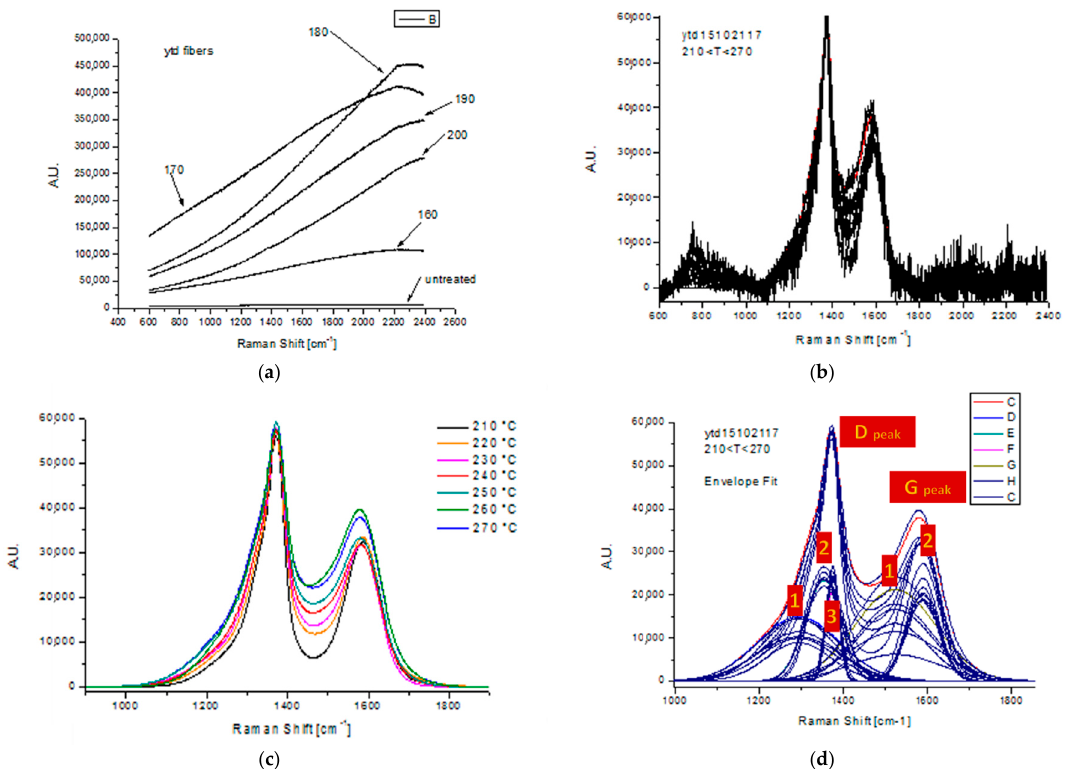
Figure 12. Raman spectra of thermally treated fibers: ( a ) isothermally treated at temperature between 160–200 °C. Isothermally treated at temperature between 210–270 °C, ( b ) after Baseline correction and subtraction, and ( c ) after noise reduction and D-peak normalization. In ( d ) the fitting process in the entire spectrum is demonstrated to measure the D-and G-peak area as presented in Table A1. Raman Data Tables.